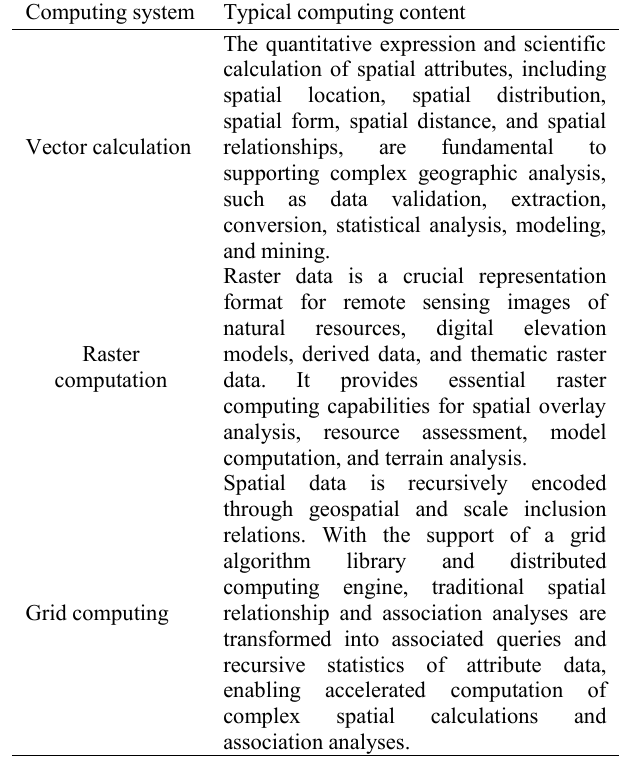
Table 1. Cloud platform spatial computing system.